Question: Write a single sentence explaining what this figure depicts.
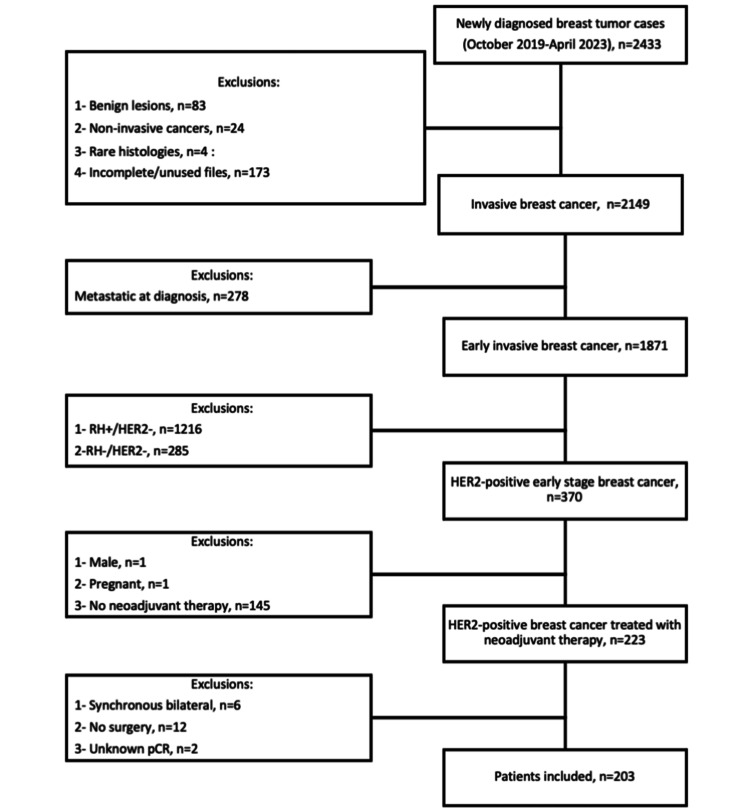
Answer: Patient selection flowchart pCR: pathological complete response; HER2: human epidermal growth factor receptor 2